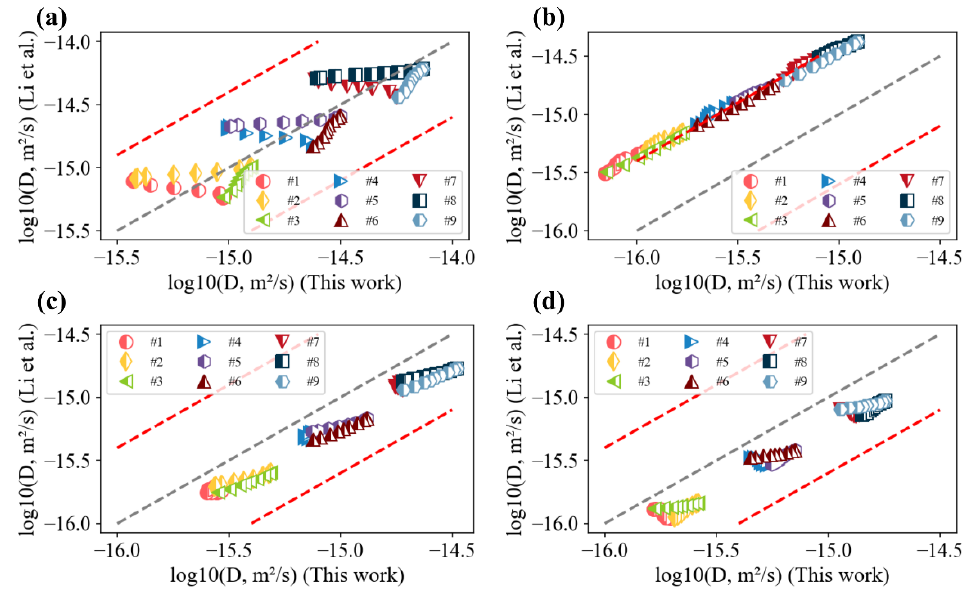
Figure 3. Comparison between the interdiffusion coefficients of different diffusion couples (noted with #1 – #3 for 1273 K and 48 h, #4 – #6 for 1323 K and 48 h, and #7 – #9 for 1373 K and 48 h, evaluated with #1–#3 for 1273 K and 48 h, #4–#6 for 1323 K and 48 h, and #7–#9 for 1373 K and 48 h,